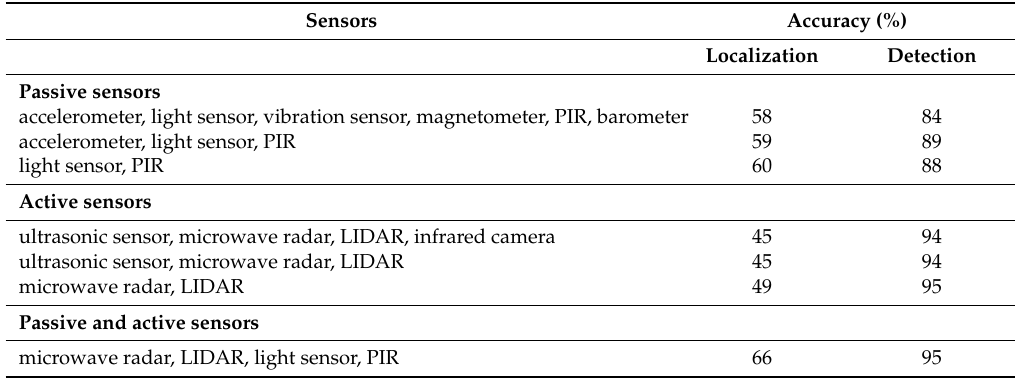
Table 10. Accuracy of pedestrian detection and localization based on combined sensor readings from